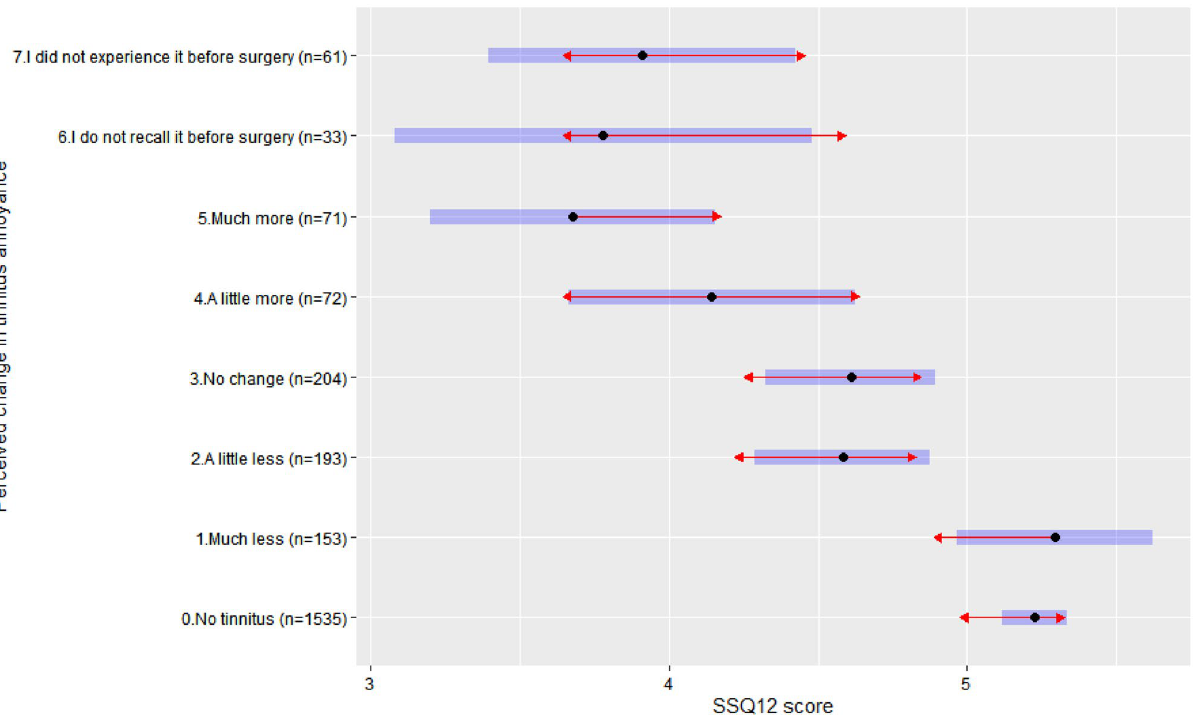
Figure 3. SSQ12 scores by perceived changes in tinnitus annoyance. Blue bars are the 95% confidence intervals for the estimated marginal means, the red arrows are for the comparisons among them. If an arrow from one group overlaps with an arrow from another group, the difference is not statistically significant (Tukey tests, p > 0.05).